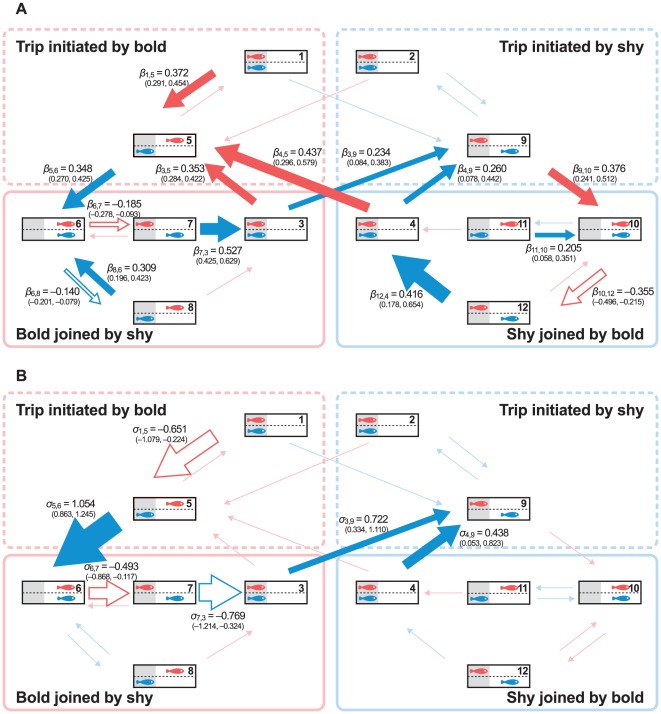
Log-linear effects of individual temperament scores.Log-linear effects of temperament scores (best estimates and 95% CI) of (A) bold individuals, and (B) shy individuals, on transition intensities. Red arrows indicate the effects of temperament scores on movements of bold individuals, and blue arrows are the effect of temperament scores on movements of shy individuals. Filled arrows: positive effects, open arrows: negative effects, arrows with lighter colour: non-significant effects. The width of each arrow indicates the magnitude of the log-linear effect.